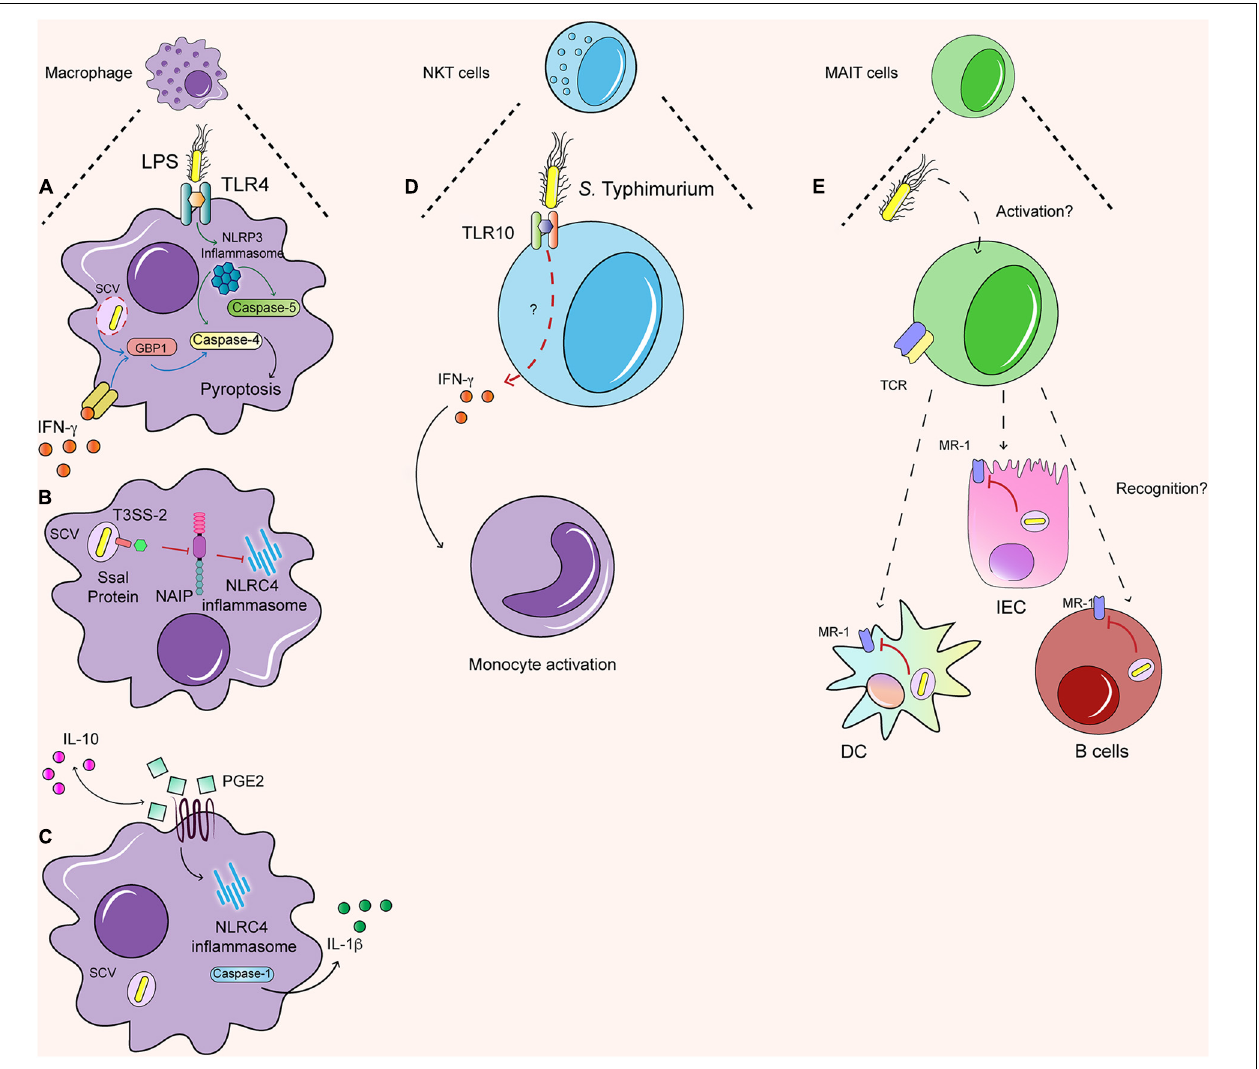
FIGURE 2 | Immune response against S. Typhimurium in human cells. (A) LPS dependent NLRP3 inflammasome induce the caspase 4/5 dependent pyroptosis. Further, the IFN- γ primed macrophages generate the same dependent pyroptosis process, but with the activation of GBP1. (B) In macrophages Ssal, an effector protein secreted by TTSS-2, can inhibit the activation of NLRC4 by the NAIP proteins. (C) IL-10 regulate the production of PGE2 and the production of IL-1 β dependent of NLRC4 inflammasome. (D) NKT cells are able to recognize S. Typhimurium possible by TLR 10, which by a non-identify pathway lead the secretion of IFN- γ that activate monocytes. (E) It is still unknown how MAIT cells are activated. When are activated, they can recognize infected DC, IEC, and B cells and secrete granzyme. However, the S . Typhimurium inside SCV can avoid the load into MR-1 and in this sense avoid the recognition by MAIT cells as